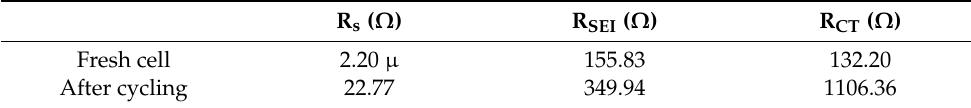
Table 1. EIS results extracted using the equivalent circuit in Figure 6d.